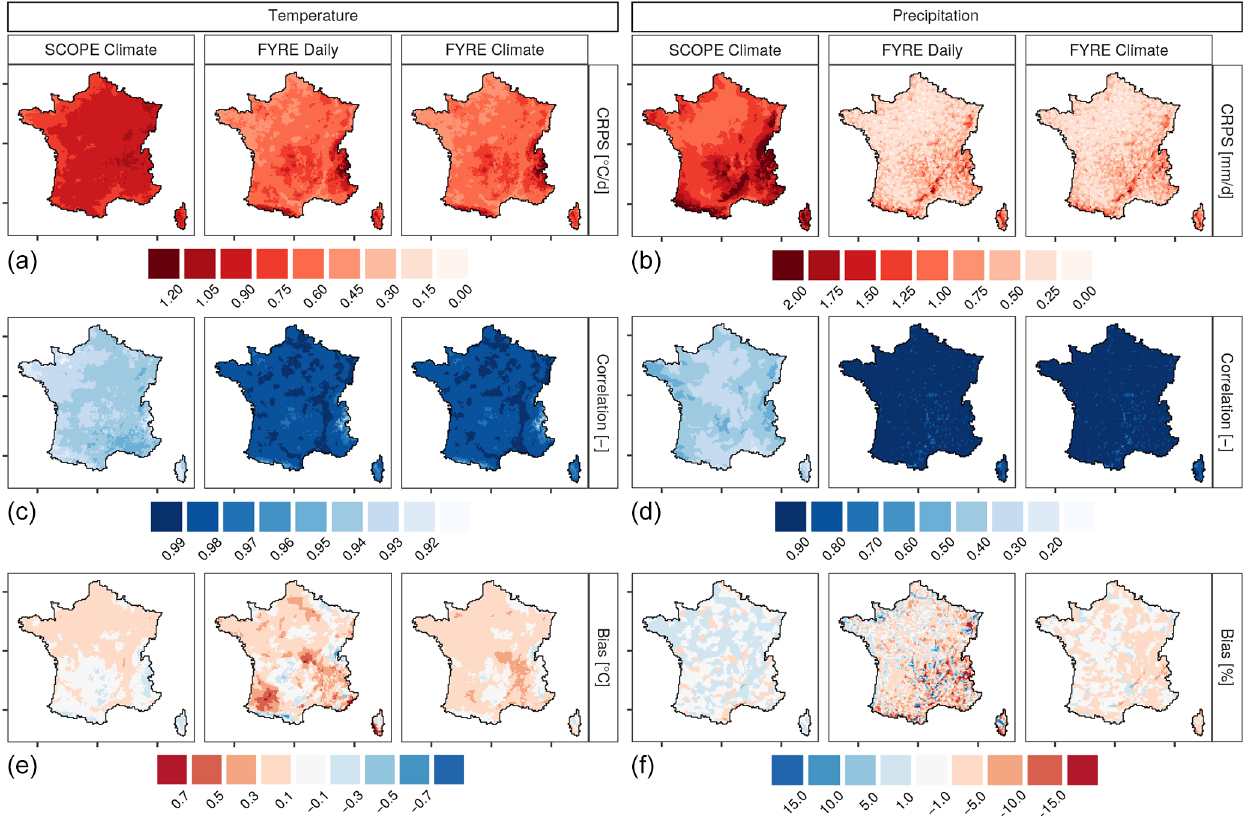
Figure 5. Mean of daily continuous ranked probability score (CRPS) (a, b) , daily correlation (c, d) and daily bias (e, f) between Safran and SCOPE Climate, FYRE Daily, and FYRE Climate for the 1960–2000 period for temperature (a, c, e) and precipitation (b, d, f) . Correlation and bias are median values over each